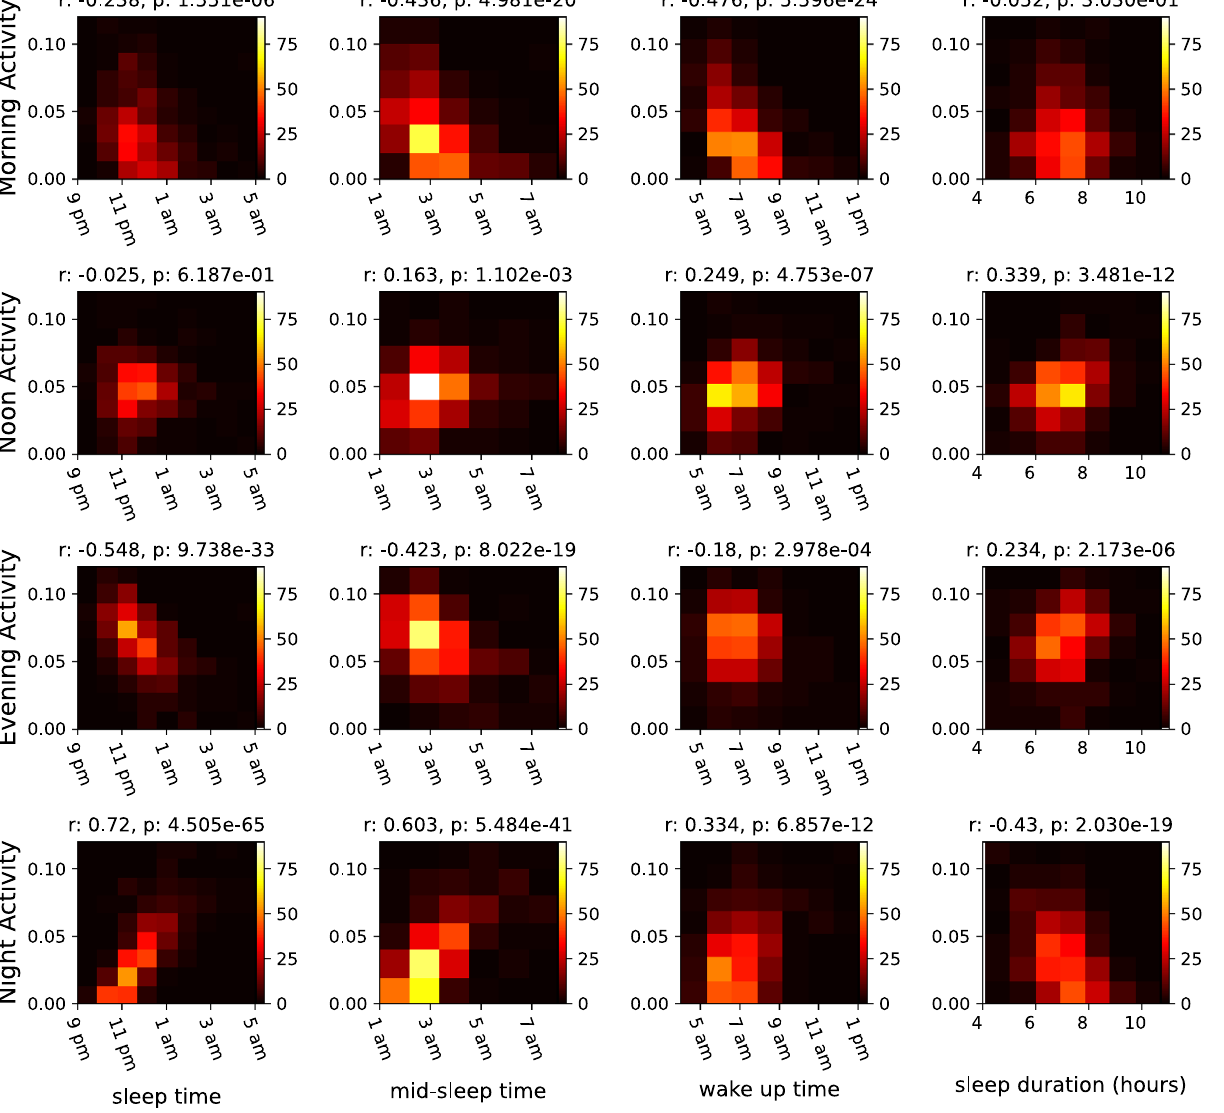
Figure 4. Correlations of different NMF components with four different parameters, from left to right: sleep time, mid-sleep time, wake-up time and sleep duration.